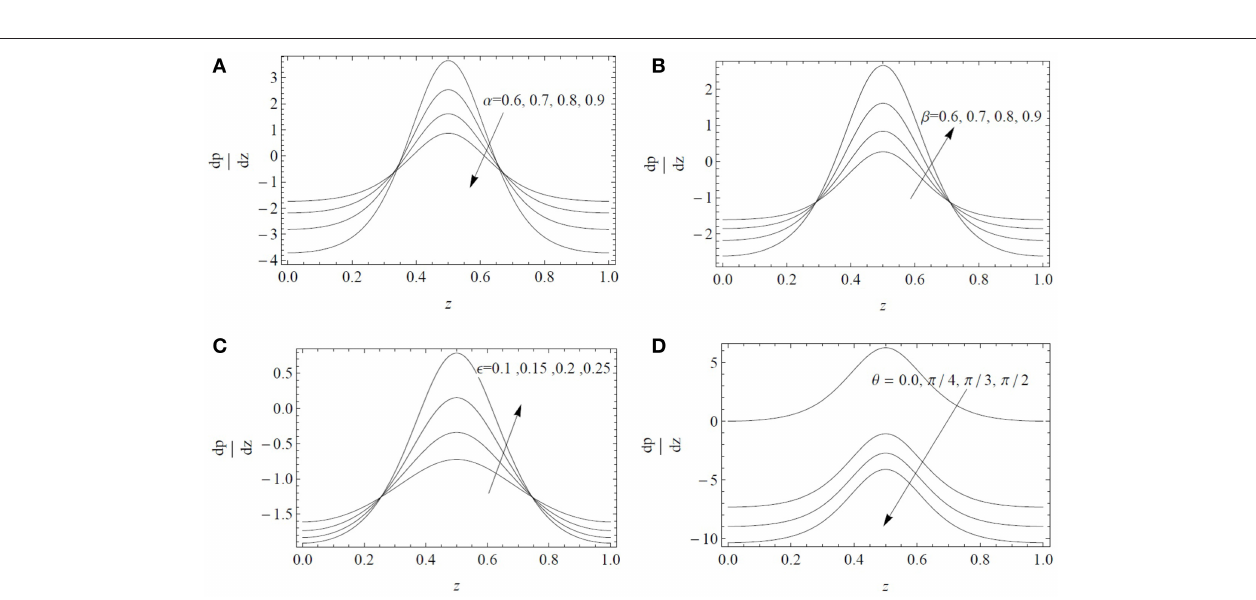
FIGURE 3 | Axial pressure gradient dp / dz as a function of the axial position z for α * = β * = 0.4, Fr = 0.1 and Re = 0.1: (A) influence of the fractional parameter α for ǫ = 0.3, β = 0.6, λ 1 = 5, λ 2 = λ 3 = 1, θ = π 3 ; (B) influence of the fractional parameter β for ǫ = 0.3, α = 0.6, λ 1 = 5, λ 2 = λ 3 = 1, θ = π 3 ; (C) influence of the cilia length ǫ for α = β = 0.6, λ 1 = 5, λ 2 = λ 3 = 1, θ = π 3 ; (D) influence of the inclination angle θ for ǫ = 0.3, α = β = 0.6, λ 1 = 5, λ 2 = λ 3 = 1.